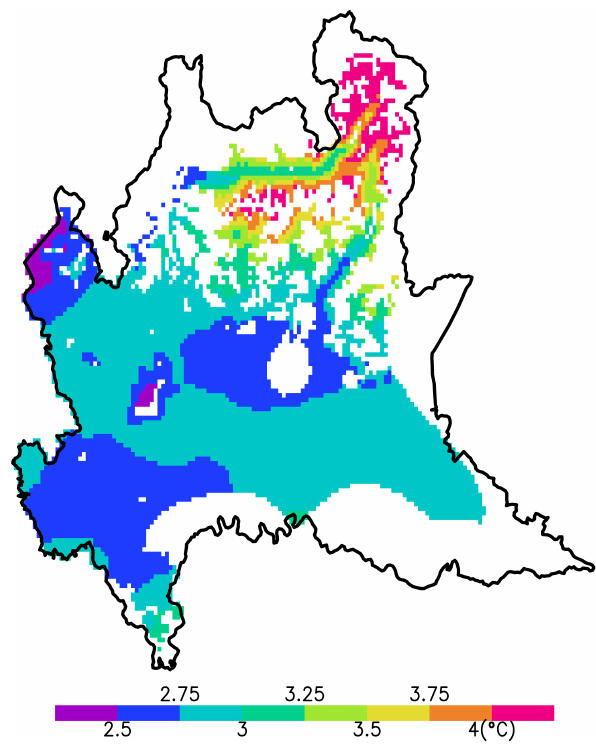
Figure 3. Winter season (December-January-February) averaged σ TN . The IDI mask has been applied (see Sect. 2). −